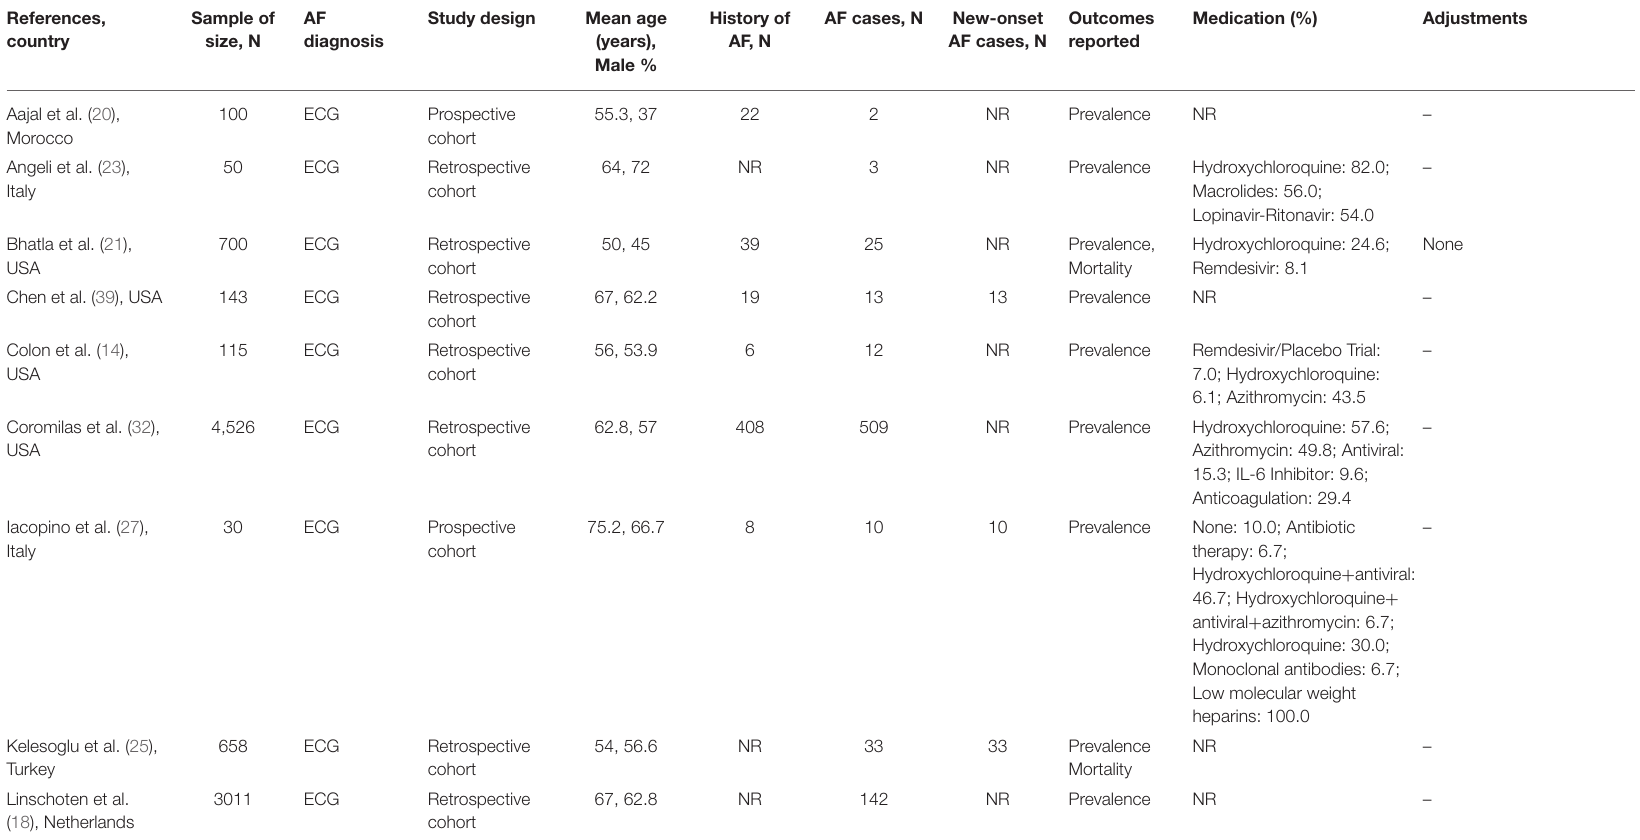
TABLE 1 | Characteristics of included studies in this